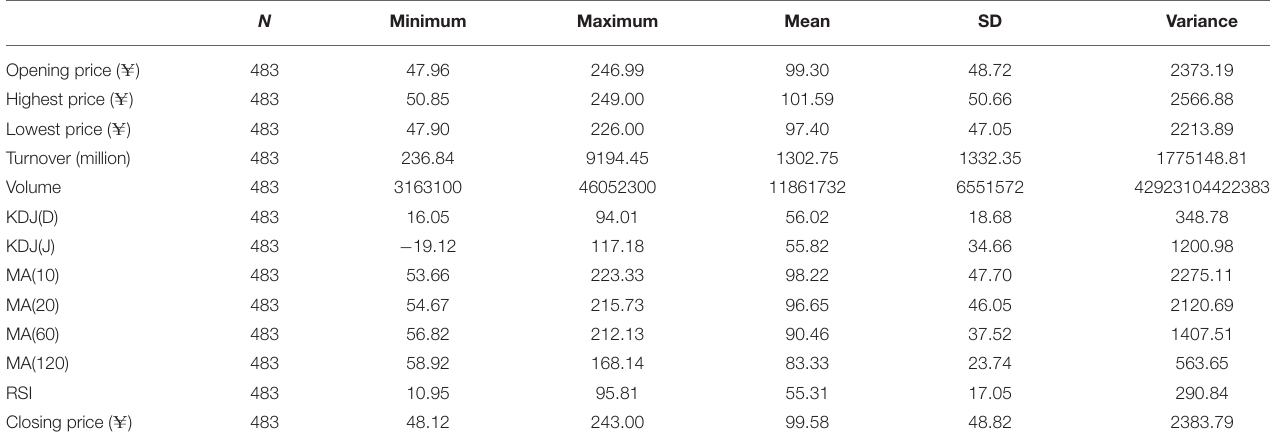
TABLE 2 | The descriptive statistical value of technical indexes for China tourism group duty-free corporation limited. N Minimum Maximum Mean SD